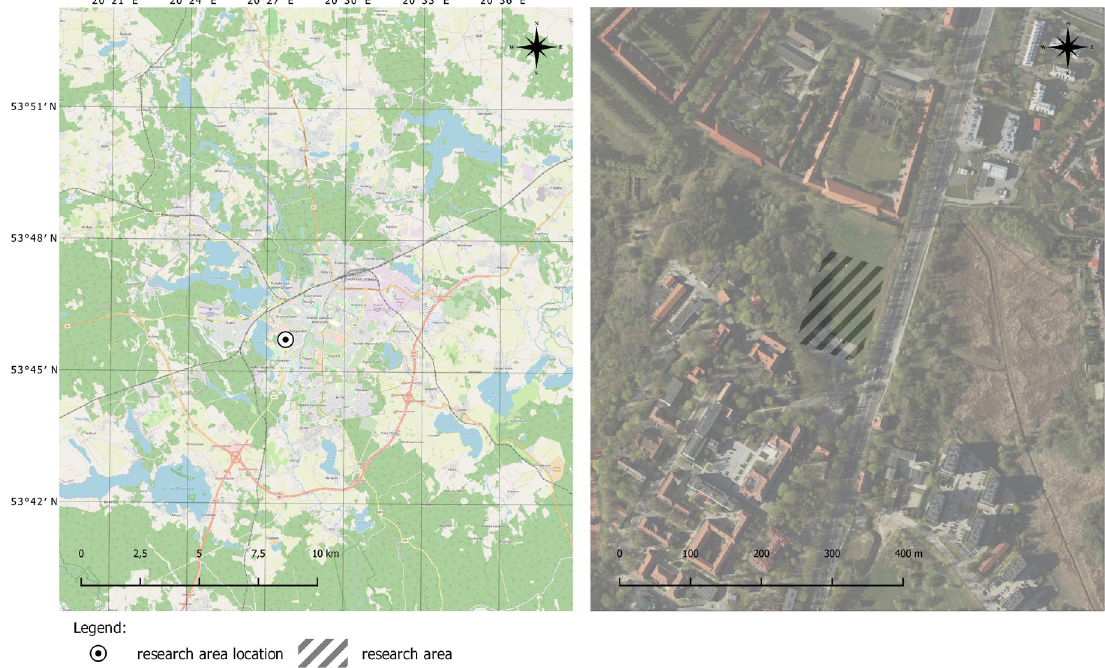
Figure 1. Research